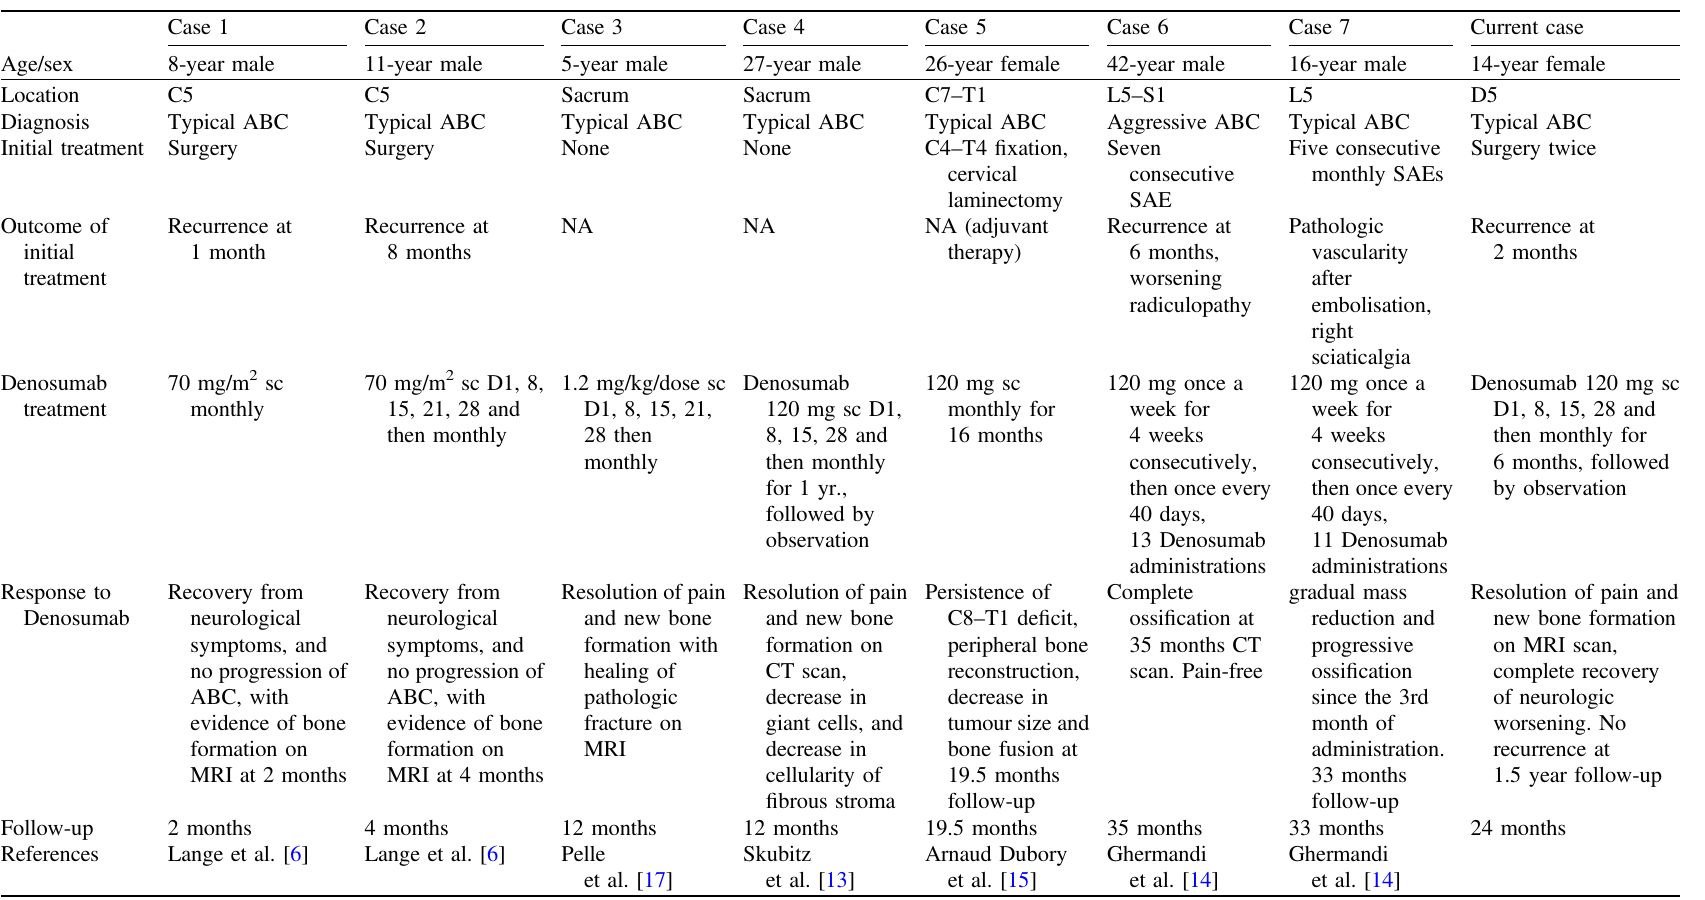
Table 1. Published and current cases of Denosumab treatment of